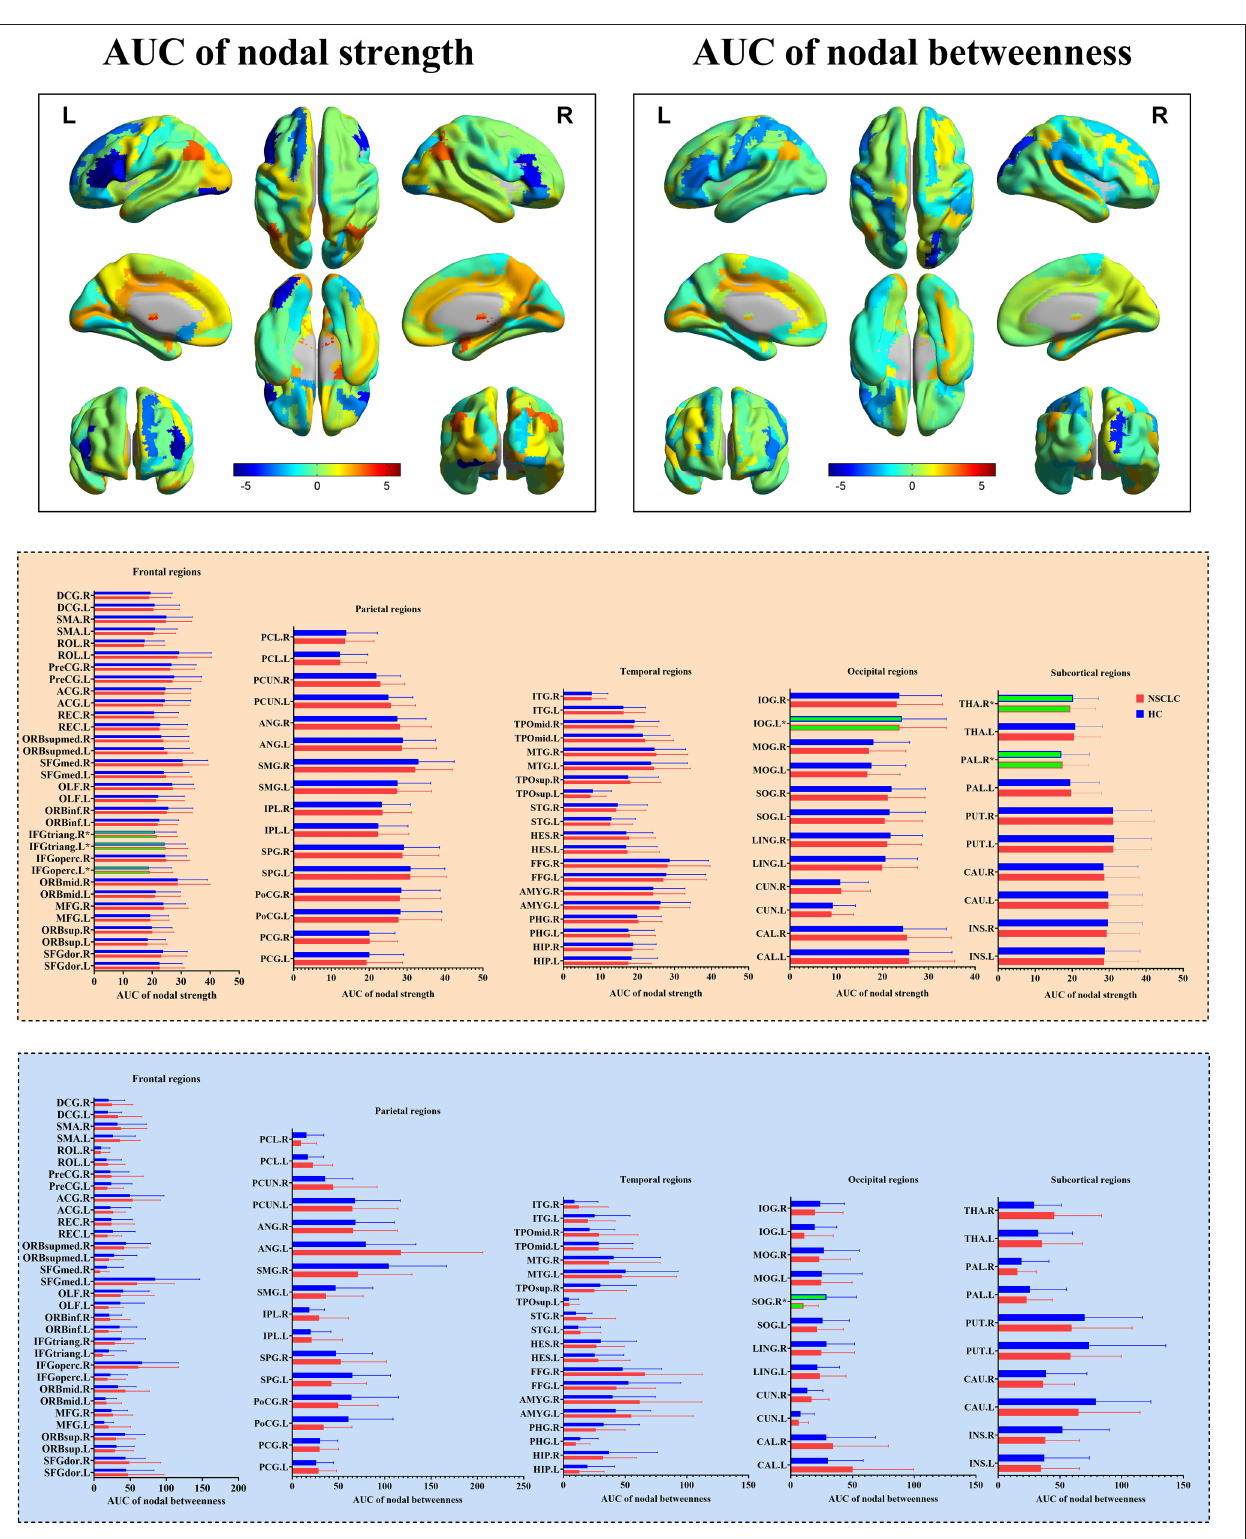
FIGURE 3 | Group differences in the nodal measures of the functional brain networks between NSCLC and HC. NSCLC, non-small cell lung cancer; HC, healthy control. The superscript * and green column indicated brain regions with significant differences surviving false discovery rate (FDR) correction. The color bar indicated t- values of the two-sample t -tests. The abbreviations of brain regions were presented in the Supplementary Material online.